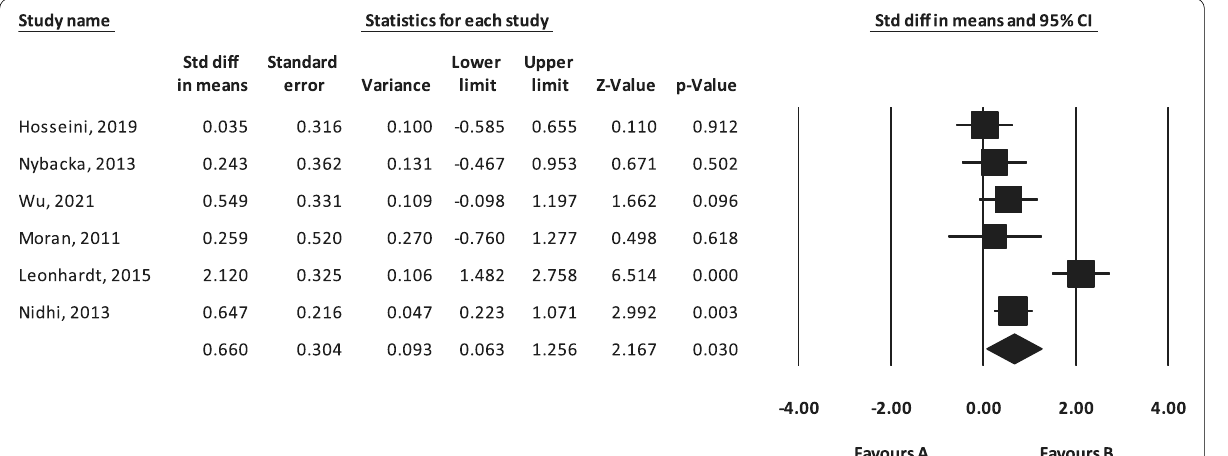
Fig. 2 Forest plot of the studies included in the meta-analysis before and after the intervention of the control group and the intervention group based on RCTs